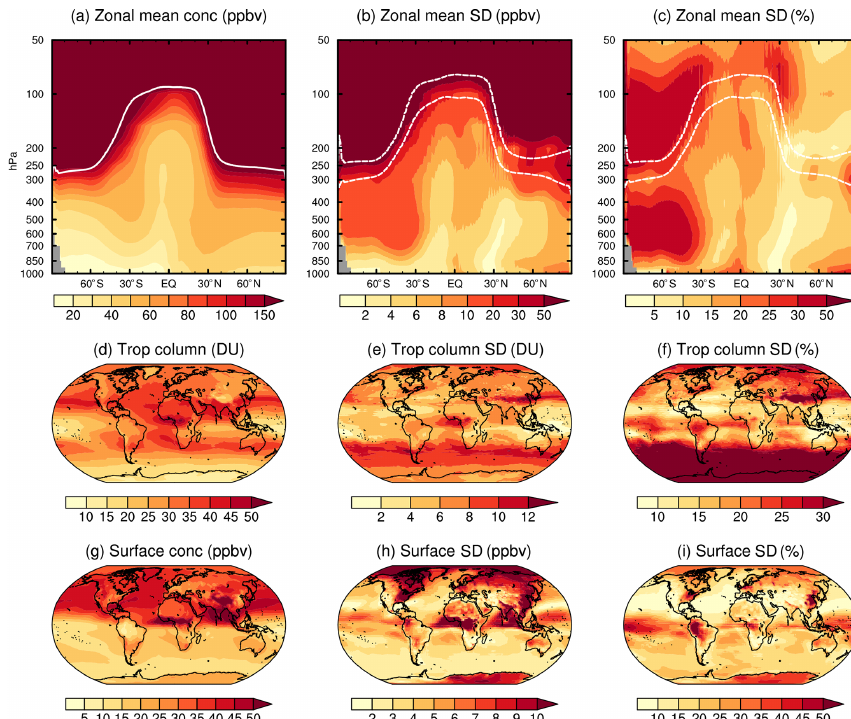
Figure 2. CMIP6 ensemble mean, annual mean ozone climatologies and their inter-model variability in the present day (2005–2014CE) of the historical simulation. Panel (a–c) shows zonal mean ozone, the middle row shows the tropospheric-ozone column, and the bottom row shows surface ozone. For each row, the left-hand panel shows the absolute values of the ozone variable: ppbv for the zonal mean and surface concentrations and Dobson units (DU) for the tropospheric column. The middle column shows the absolute inter-model standard deviations in the same units. The right column shows the standard deviation as a percentage of the ensemble mean value. The top row of panels (a, b, c ) also shows the multi-model zonal mean tropopause pressure (a, d, g) , and the mean ± 1 standard deviation of the multi-model variability. Note that each panel has a different scale. This is an updated version of Fig. 3 of Young et al.